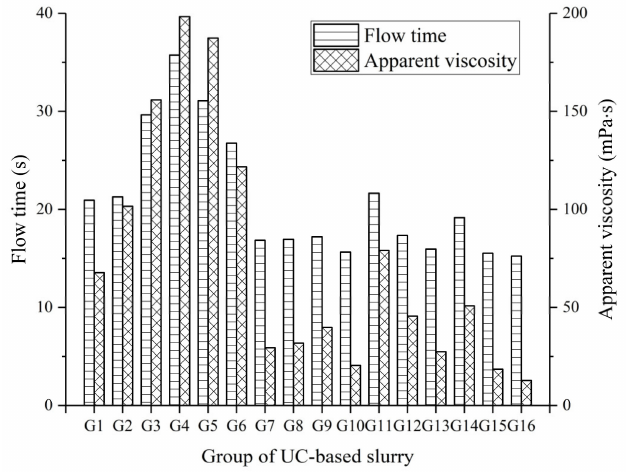
Figure 6. Flow time and apparent viscosity of the UC-based